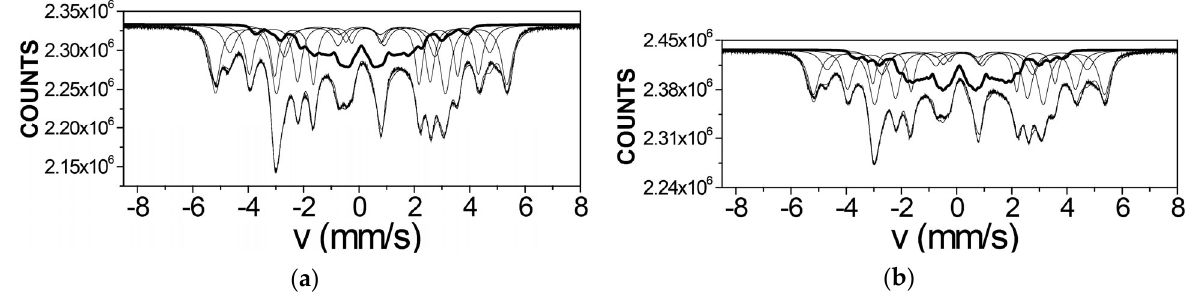
Figure 73. Room temperature Mössbauer spectra of FINEMET samples FT1 with permeability μ r = 1350 ( a ) and FT2 with permeability μ r = 6000 ( b ). Adapted from Ref. [101] with permission from µ r = 1350 ( a ) and FT2 with permeability µ r = 6000 ( b ). Adapted from Ref. [101] with permission from